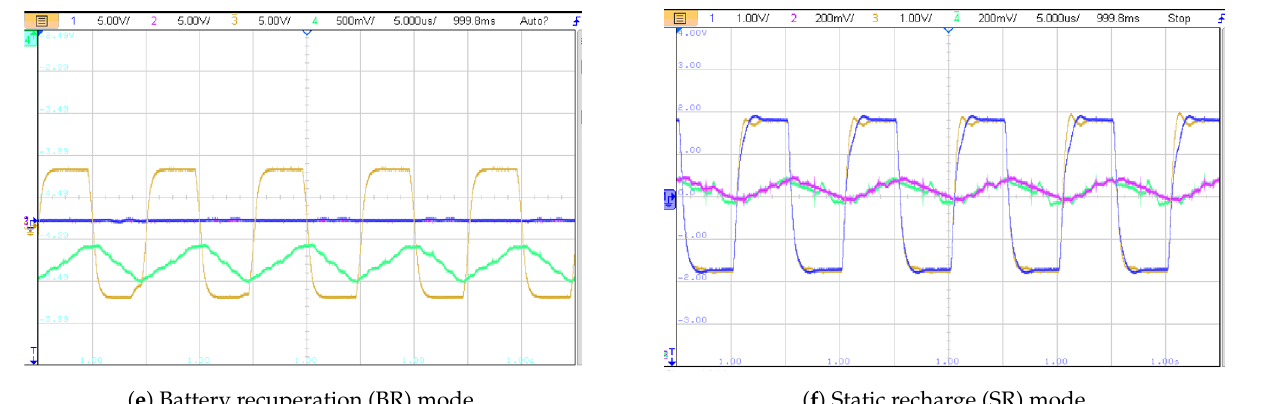
Figure 23. Experimental results of inductor waveforms of the voltage balancing stage (CH1 (blue): L 1 voltage, CH2 (red): L 1 current, CH3 (yellow): L 2 voltage, CH4 (green): L 2 current) for all six modes.